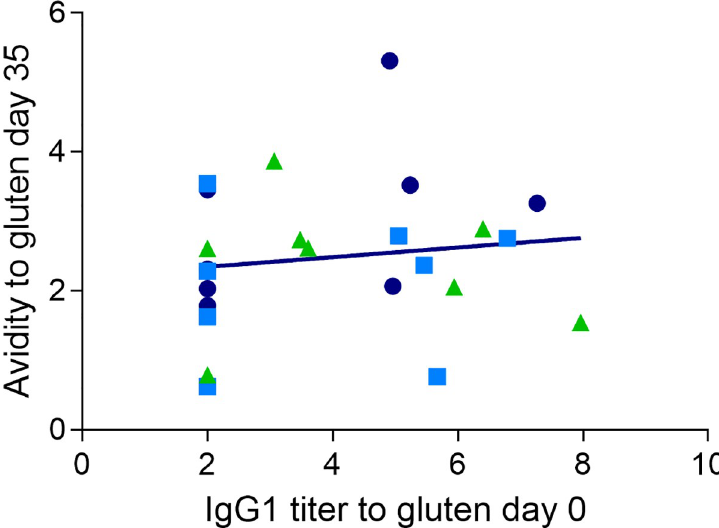
Fig 6. Relation between specific IgG1 titer to gluten day 0 and avidity (IC50) to gluten day 35, after three i.p. doses of G (cirkels), EHG (squares) or AHG (triangles). Each dot represents an animal. A titer of 2 is the cut-of value i.e. no measurable antibodies (p =